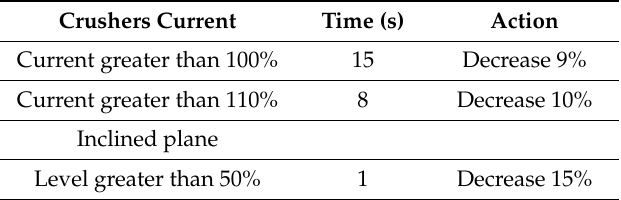
Table 6. Secondary and Tertiary Crushing